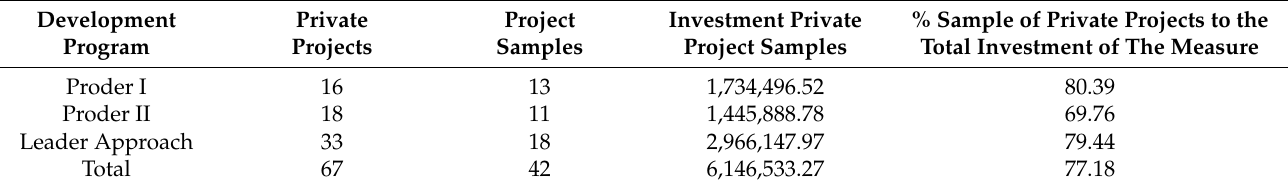
Table 2. Sample of private tourism projects in the region of La Vera.